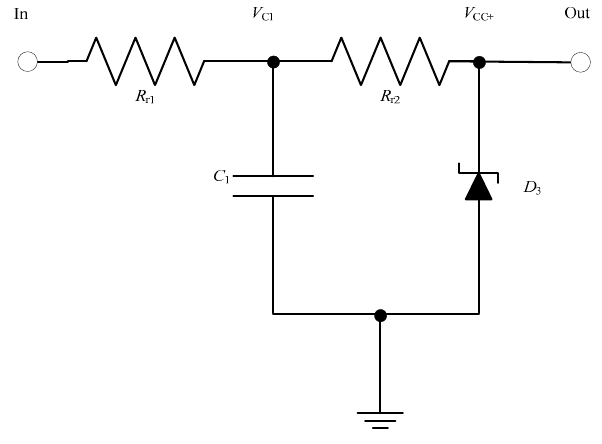
Figure 9. Circuit diagram of